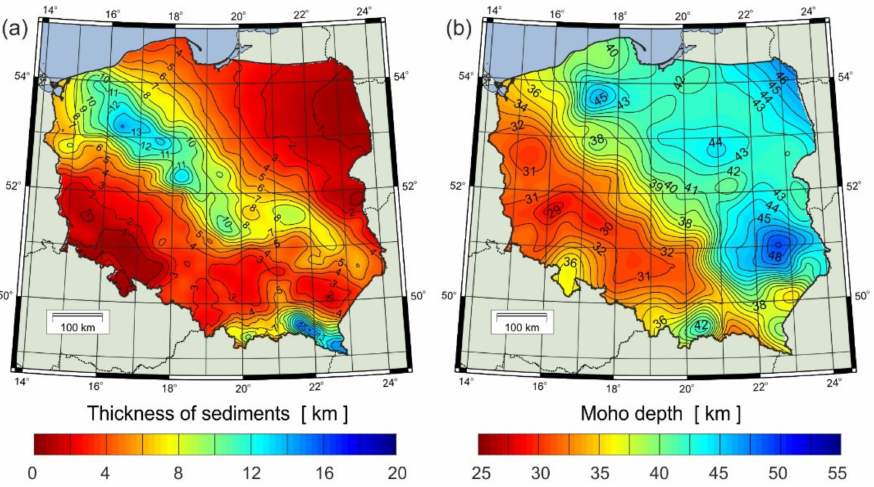
Figure 2. Thickness of sedimentary succession ( a ) and Moho depth ( b ) in Poland from Grad et al. [21],